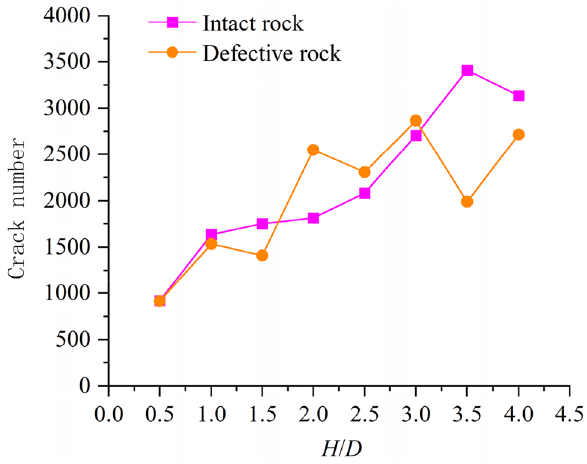
Figure 10. Relationship between crack number and aspect ratio of rock